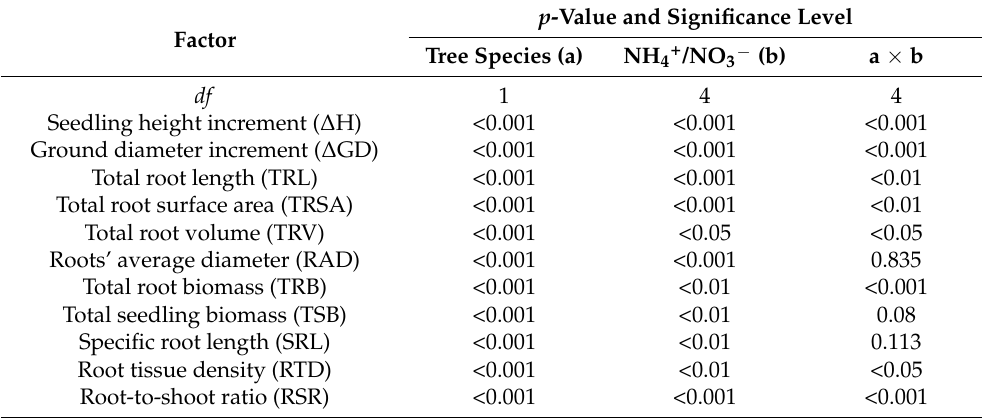
Table 2. Two-way ANOVA of the effects of tree species and different ratios of N forms on the seedlings’ growth and the roots’ morphological